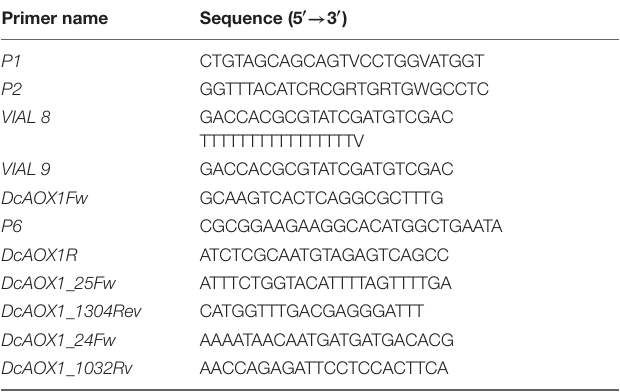
TABLE 2 | Primers used for DcAOX1 gene